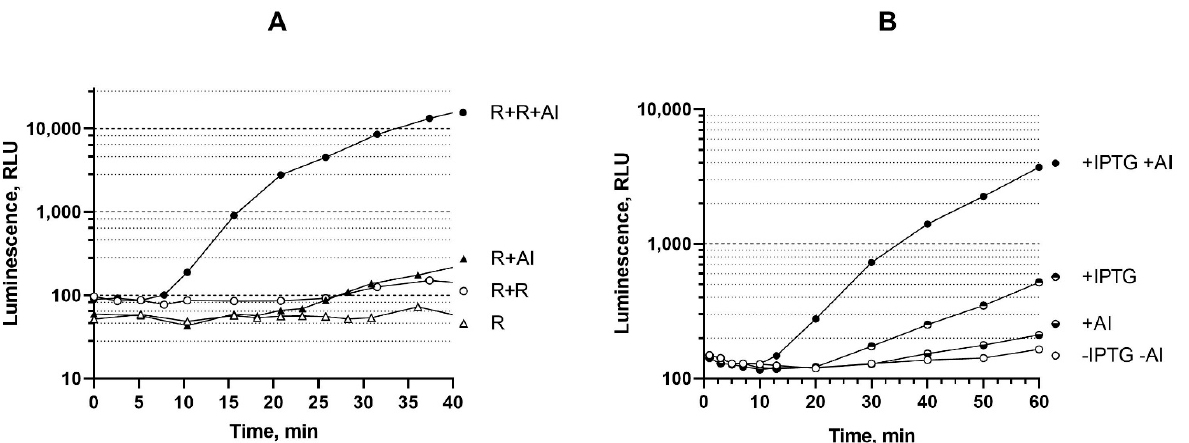
Figure 4. ( A ) Time-dependent luminescence of E. coli MG1655 cells carrying plasmid pVFR1 (R) and a combination of plasmids pVFR1 pSVRAF (R + R) after addition of AI to a final concentration of 10 nM. ( B ) Time-dependent luminescence of E. coli MG1655 (pR2, p15Tc luxR1) cells after the addition of 1 mM IPTG and/or 1 µ M AI. Curves show dependencies for a single experiment which are characteristic for a raw of three independent